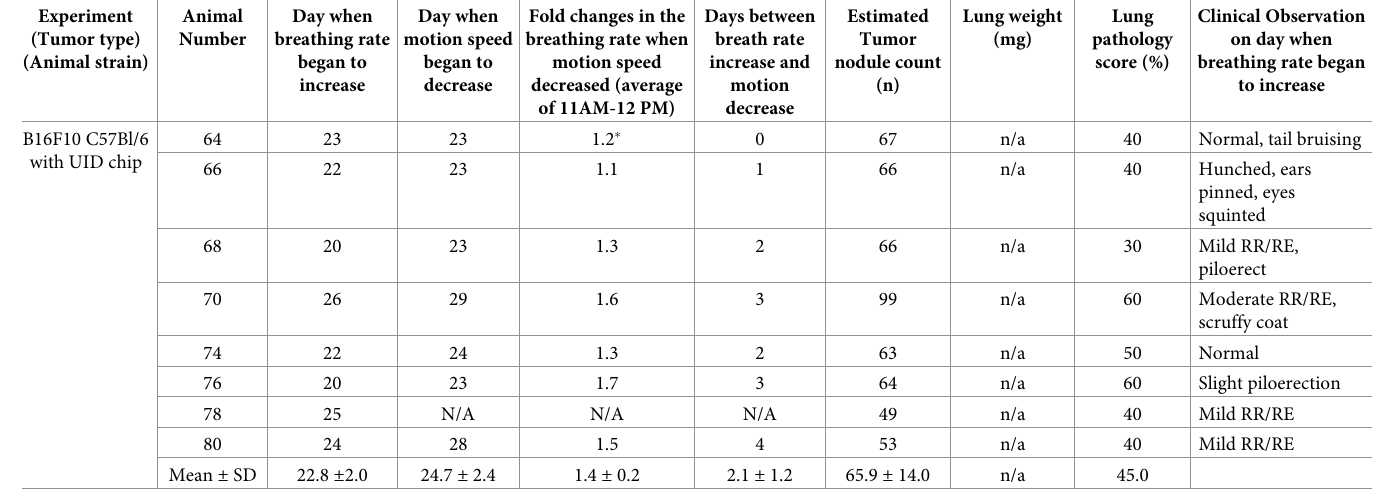
decreased locomotion speed from days 24–29 (26.8 ± 1.5), compared with the baseline values. Table 1 and Fig 2 show the initial days of breathing rate increases, motion speed decreases and the breathing rate values when the motion speed began to decrease. When the animals began to show decreased motion speed, the corresponding average breathing rate was 246.4 ± 28.0 BPM, which is significantly higher than that of the other 6 vehicle mice from days 23–29 (163.5 ± 6.3 BPM, P < 0.001, unpaired t -test, Table A in S1 File). In contrast, the vehicle injected animals did not show any changes in breathing rate between days 14 to 28 (Fig 3 and S2 File). Interestingly, detailed analysis indicated that the breathing rate increase did not corre- late to either the estimated counts of tumor nodules (R 2 = 0.24, P > 0.05, Fig 4A), lung pathol- ogy score (R 2 = 0.29, Fig 4C) or lung weight (R 2 = 0.07, Fig 4F). In CT26 BALB/c with UID chip experiment, 8 out of 10 animals with metastatic tumors in the lungs began to manifest increased respiratory rates from days 19–22 (20.1 ± 0.9) accompanied with decreased motion speed from days 20–22 (21.0 ± 0.7), compared with the baseline. Table 1 and Fig 5 and S6 and S12 Files show the initial days of breathing rate increases, motion speed decreases and the breathing rate values when the motion speed begins to decrease. When the animals began to show decreased motion speed, the corresponding average breathing rate was 290.7 ± 37.6 BPM, which is statistically significantly higher than that of other 8 control mice from days 17– 22 (170.6 ± 10.7, P < 0.001, unpaired t -test, Table A in S1 File). In contrast, the control animals did not show breathing rate changes from days 13 to 22 (Fig A in S1 File). Further analysis indicated that the breathing rate increase did not correlate to either the estimated counts of tumor nodules (R 2 = 0.24, P > 0.05, combined with the data from CT26 BALB/c experiment, Fig 4A). The lung pathology scores of the tumor-bearing animals showing increased breathing rate ranged from 30–80%, while those without breathing rate increases had pathology scores ranged from 10–40% (Table 1 and Table B in S1 File). No changes in body weight or temperature in BALB/c mice with CT26 cells The CT26 tumor-bearing and vehicle-injected animals showed similar body weight gain